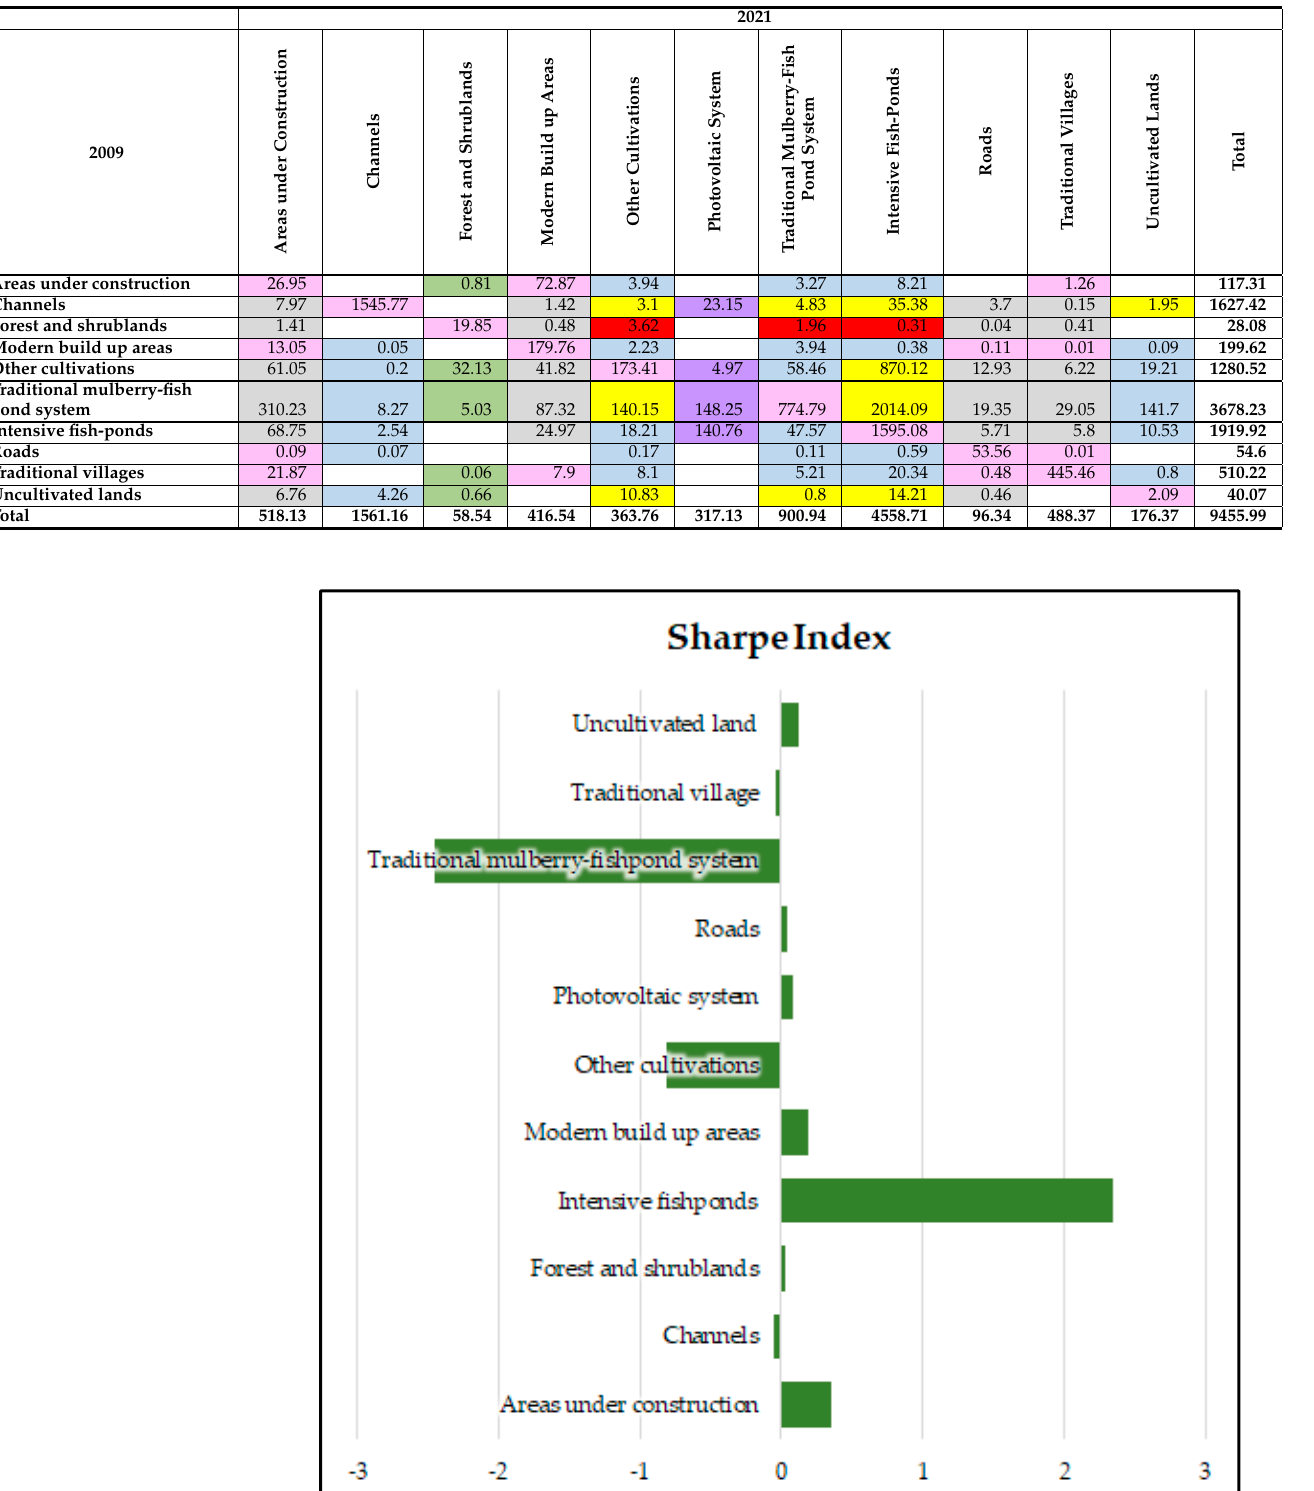
Figure 6. Sharpe Index graph.